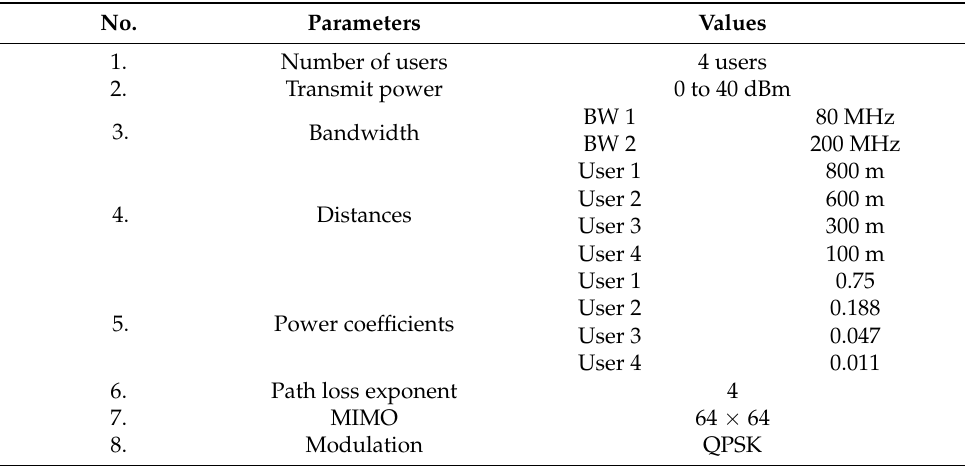
Table 1. Simulator parameters for the DL